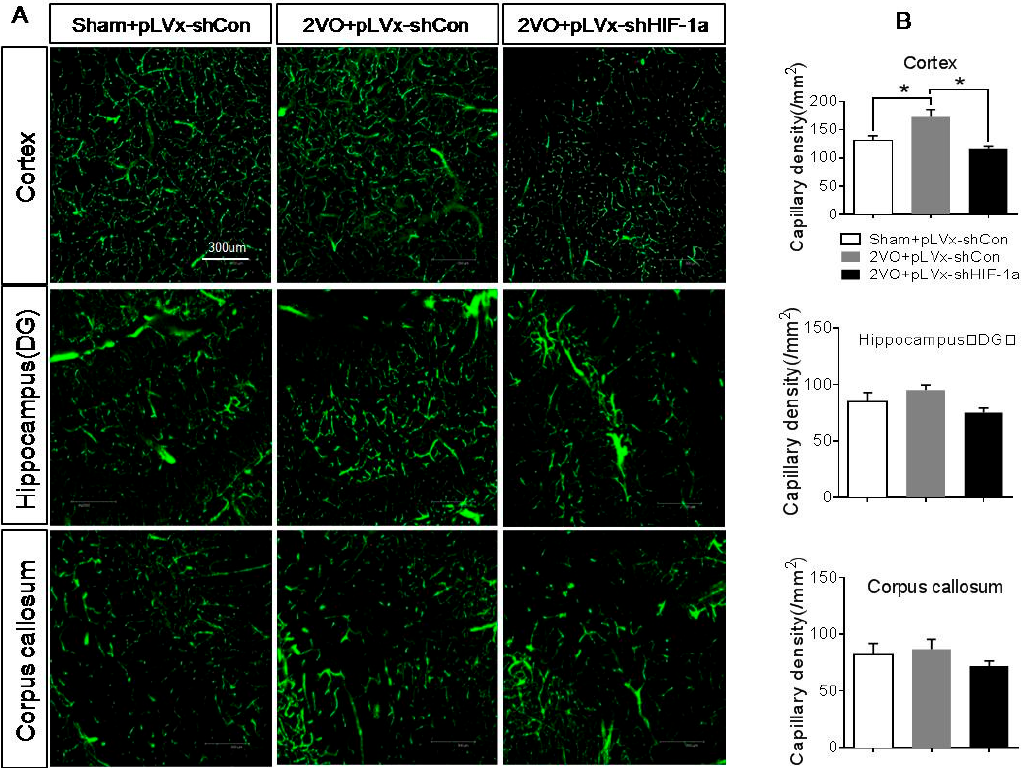
Figure 4. The effects of HIF-1 α knockdown on CCH-induced angiogenesis. ( A ) Representative images of FITC-dextran-perfused vessels in the hippocampus, cortex, and corpus callosum four weeks after 2VO or sham surgery with or without HIF-1 α -knockdown treatment. Bar = 300 µm (the magnification of all images is consistent); ( B ) the quantitative capillary density. Capillary density was expressed as the number of capillaries (diameter <12 µm) per square millimeter. Values are expressed as mean ± SEM ( n = 4). * p < 0.05 (One-way ANOVA followed by Bonferroni post hoc tests).